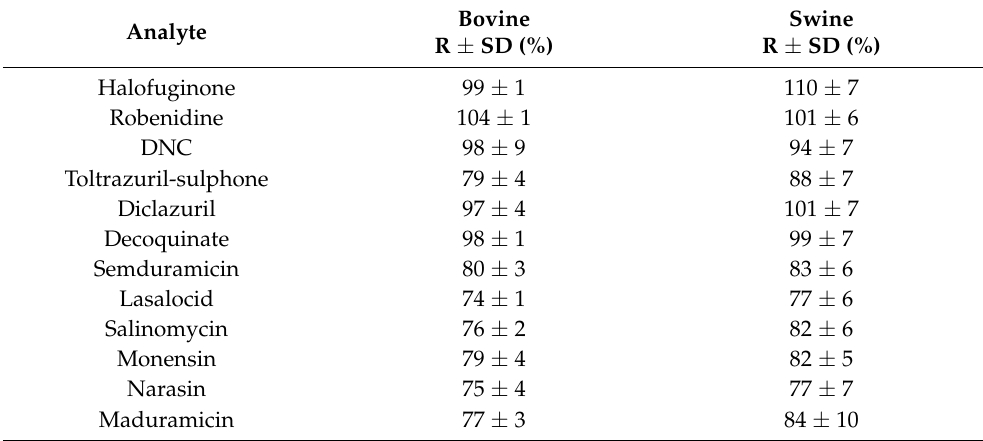
Table 5. Recovery factors and standard deviations in bovine and swine muscle samples at 10 µ g kg − 1 .